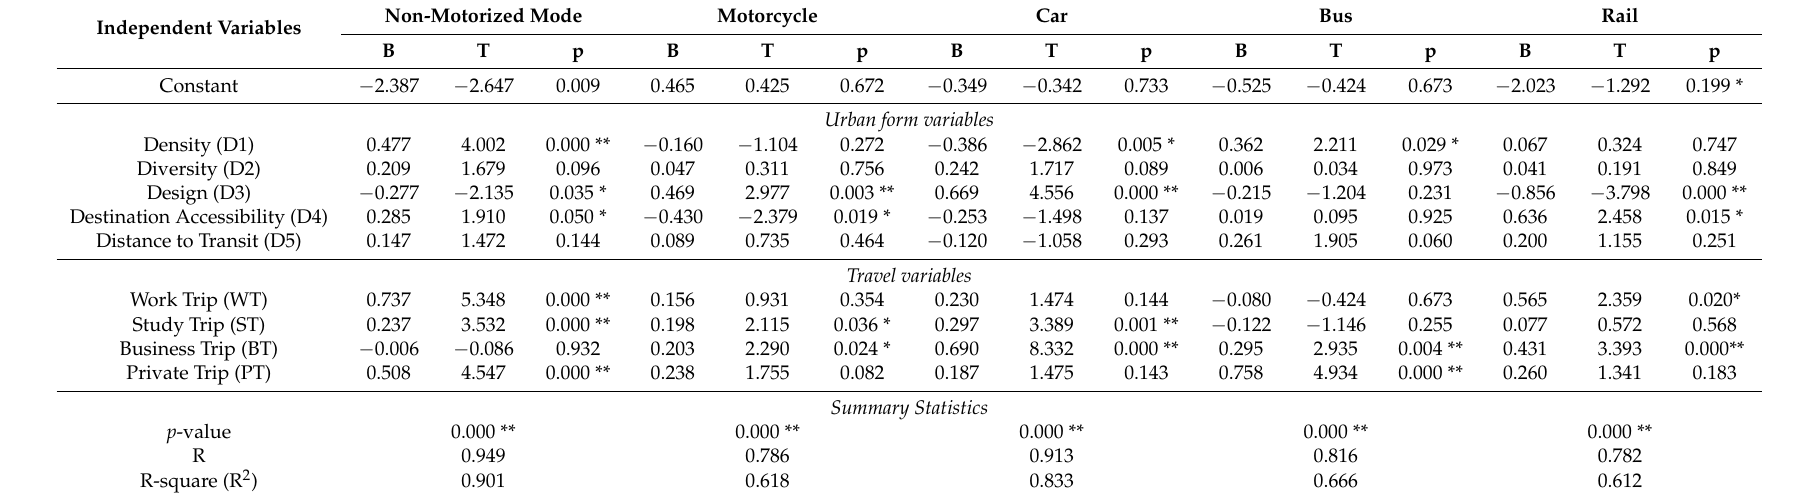
Table 5. Mode wise stratified regression